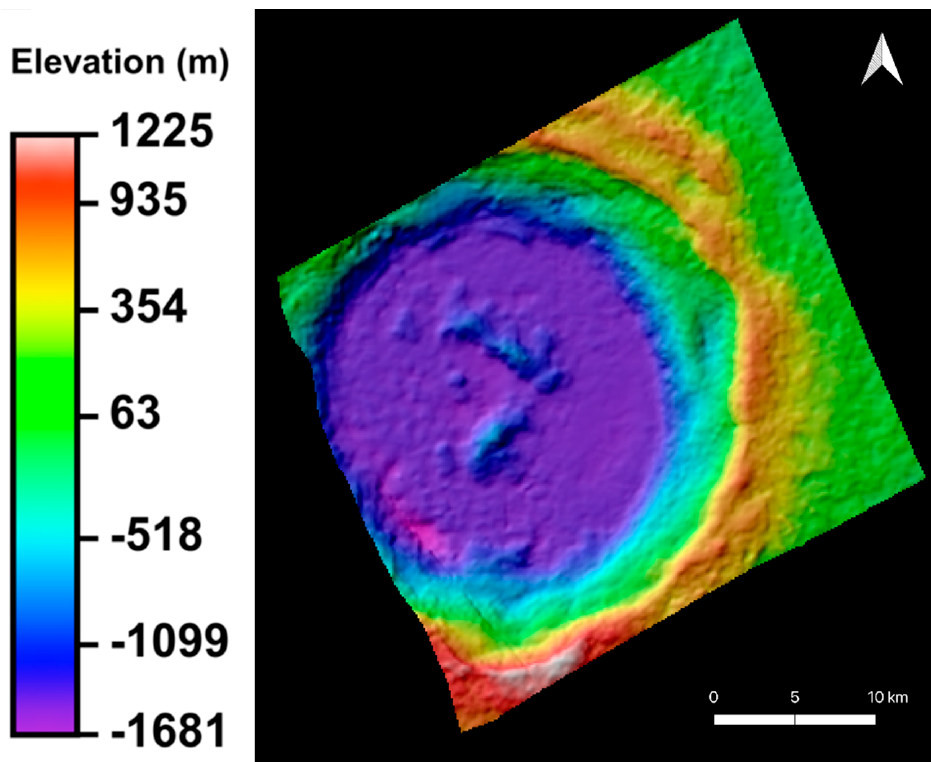
Figure A5. Kertész Crater. Figure A5. Kert é sz